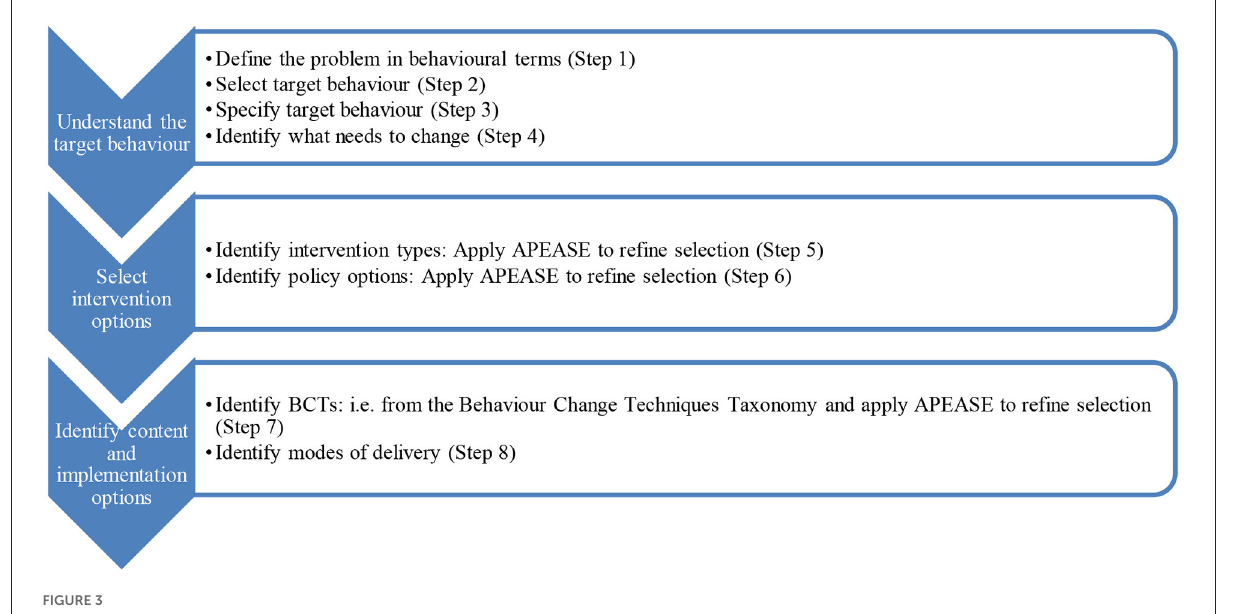
FIGURE3 The Behaviour Change Wheel’s systematic and theory driven intervention development approach.